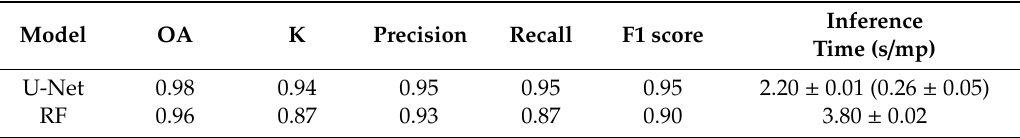
Table 3. Accuracy assessment and central processing unit (CPU) inference time for the testing tiles using the final network model (U-Net) and a random forests (RF) model. For the U-Net GPU inference time is provided in brackets additionally.